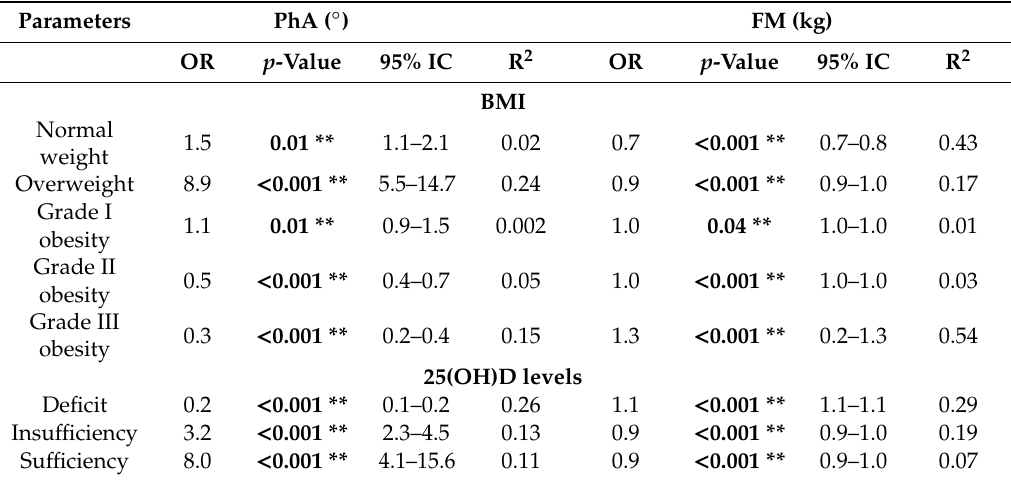
Figure 4. Correlation between 25(OH)D levels and PhA after adjusting for BMI and FM. A * p value denotes a significant di ff erence ( p < 0.05). Table 4. Bivariate proportional odds ratio model to assess the association among PhA and FM, respectively, with BMI and 25(OH)D